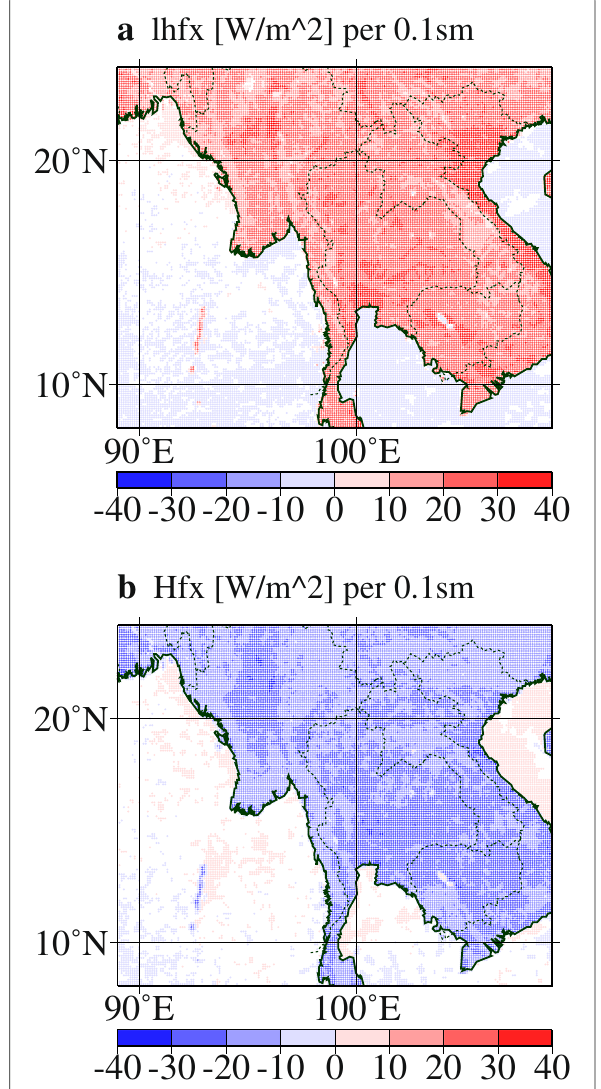
Fig. 4 Same as Fig. 3 but for a latent heat and b sensible heat fluxes. The units are W m − 2 per 0.1 increase in soil moisture, respectively